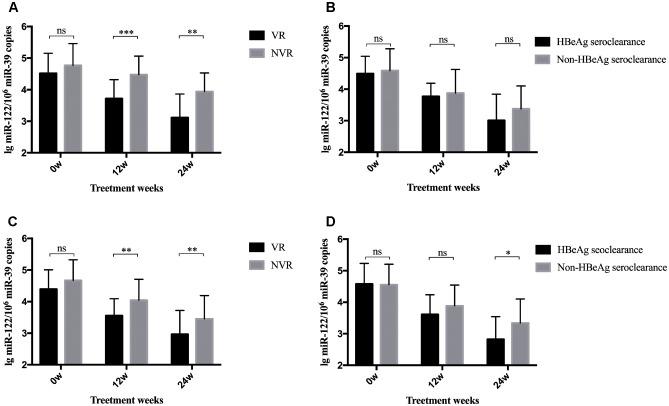
Differential levels of serum miR-122 among subgroups. The bars represent the mean and standard error of mean. (A) MiR-122 levels in serum at baseline, week 12, and week 24 among patient groups whether a VR was achieved at week 96. (B) MiR-122 levels at baseline, week 12, and week 24 among patient groups whether HBeAg clearance was achieved at week 96. (C) MiR-122 levels in serum at baseline, week 12, and week 24 among patient groups whether a VR was achieved at week 48. (D) MiR-122 levels at baseline, week 12, and week 24 among patient groups whether HBeAg clearance was achieved at week 48. VR, virological response; NVR, non-virological response; ns, not significant; ∗p < 0.05; ∗∗p < 0.01; ∗∗∗p < 0.001.